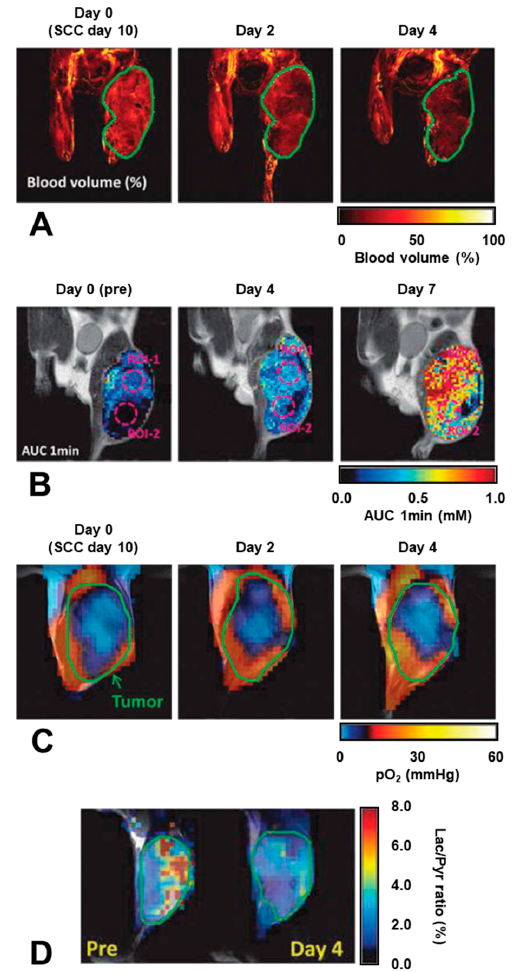
Figure 15. Effect of anti-angiogenic drug sunitinib treatment on tumor blood volume, Gd-DTPA uptake, pO 2 , and glycometabolism. ( A ) Blood volume images in SCCVII tumor on a mouse leg observed by MRI with blood pooling T 2 contrast agent USPIO before and after 2 and 4 days of daily sunitinib treatment. ( B ) Area under the curve (AUC) images of the first minute after Gd-DTPA injection. ( C ) EPR oxygen images obtained before and after 2 and 4 days of daily sunitinib treatment. ( D ) The 13 C labeled lactate/pyruvate ratio images calculated from the 13 C chemical shift images. The figure was partly modified from our previous report [137].